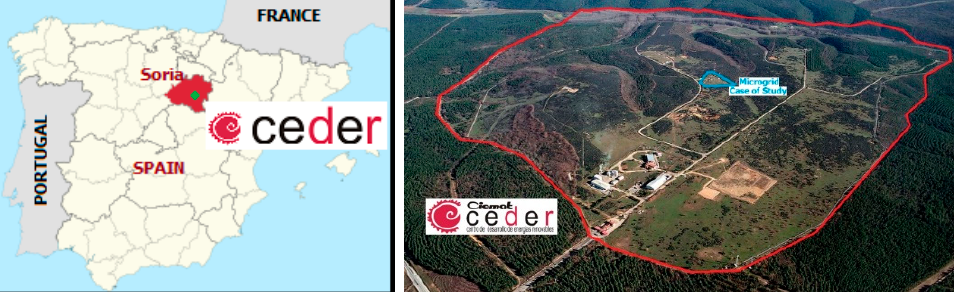
Figure 4. CEDER location and distribution. Source: prepared by authors.